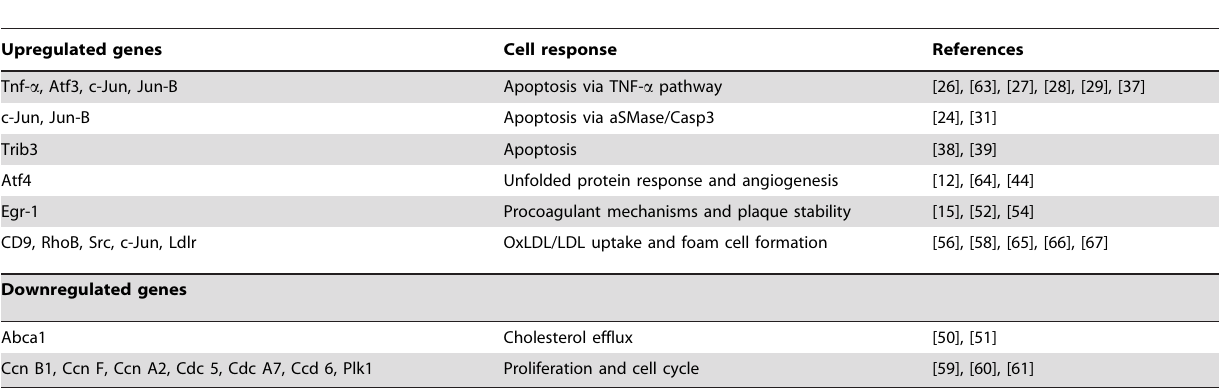
Table 3. Processes described to be affected by genes regulated in PGPC treated RAW264.7